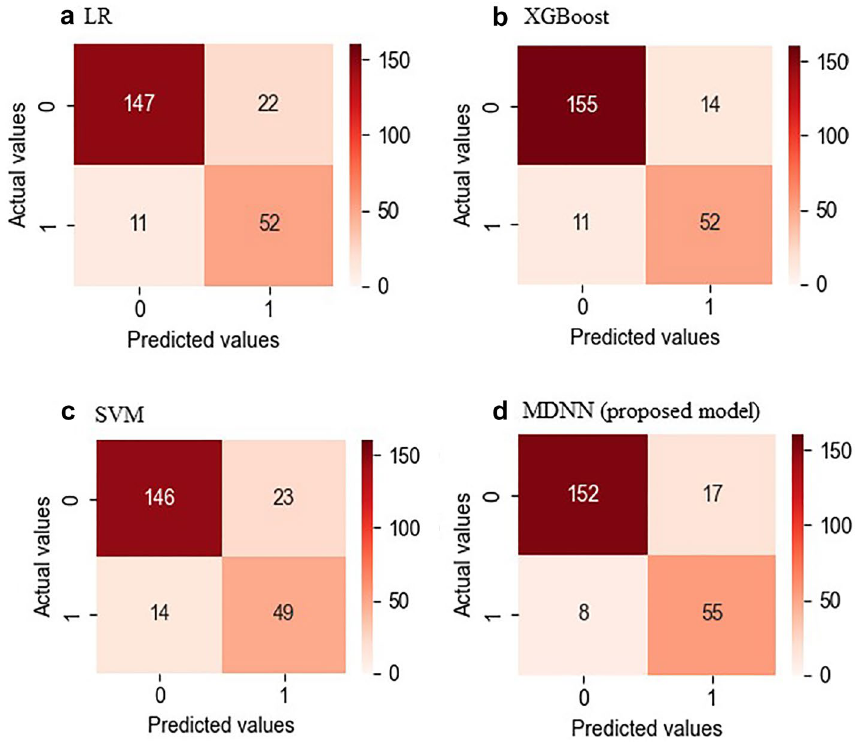
Figure 4. Confusion matrices for the entire dataset. ( a ) Linear regression (LR), ( b ) extreme gradient boosting decision tree regressor (XGBoost), ( c ) support vector machine (SVM), ( d ) multimodal deep neural network (MDNN) (0, non-intubation case; 1, intubation case).